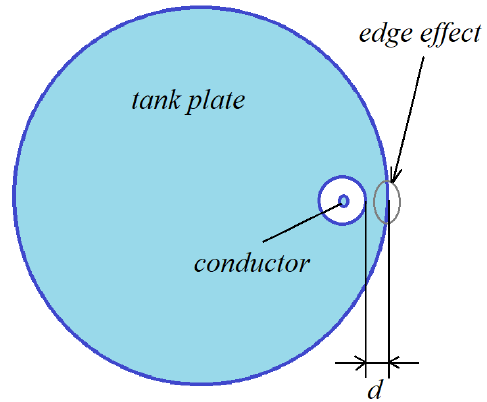
Figure 8. Limiting case of a conductor close to the plate